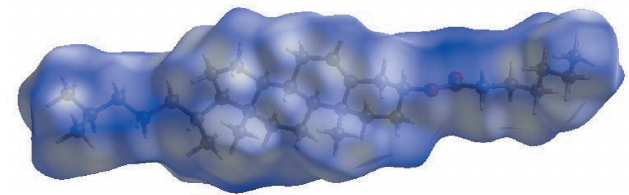
Figure 3 View of the three-dimensional Hirshfeld surface of the title compound plotted over d norm in the range of 0.0196 to 1.7047 a.u.